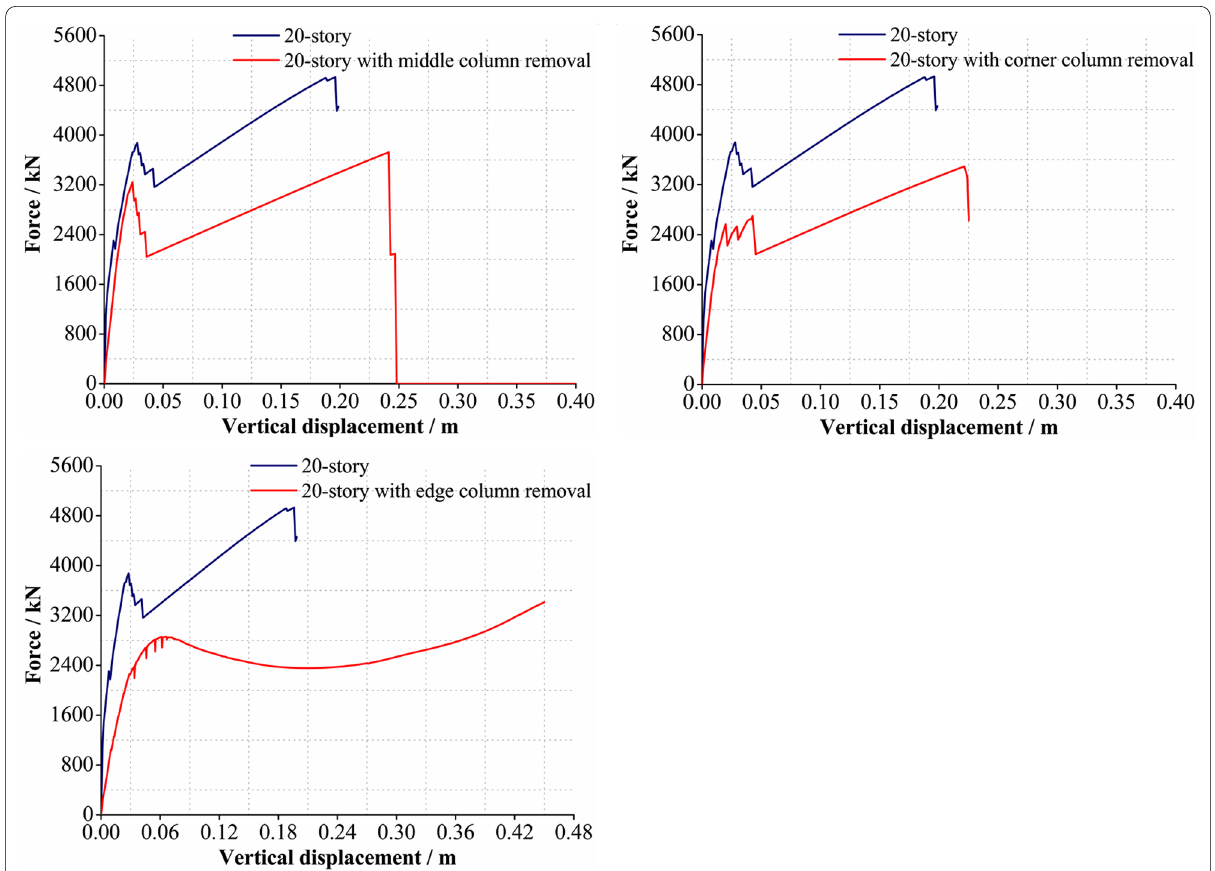
Fig. 5 Force–displacement curves of the 20-story frames with and without column removal in different locations (middle, corner, and